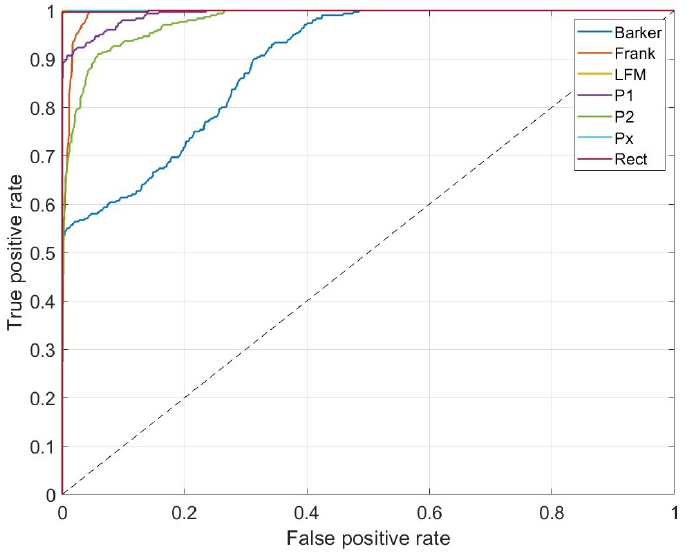
Figure 13. One-versus-all ROC curves for each class for the method with SPWVD with Kaiser window and α = 1. Table 8. Classification report of the model with SPWVD applied (Precision, Recall, and F1-Score). Signal